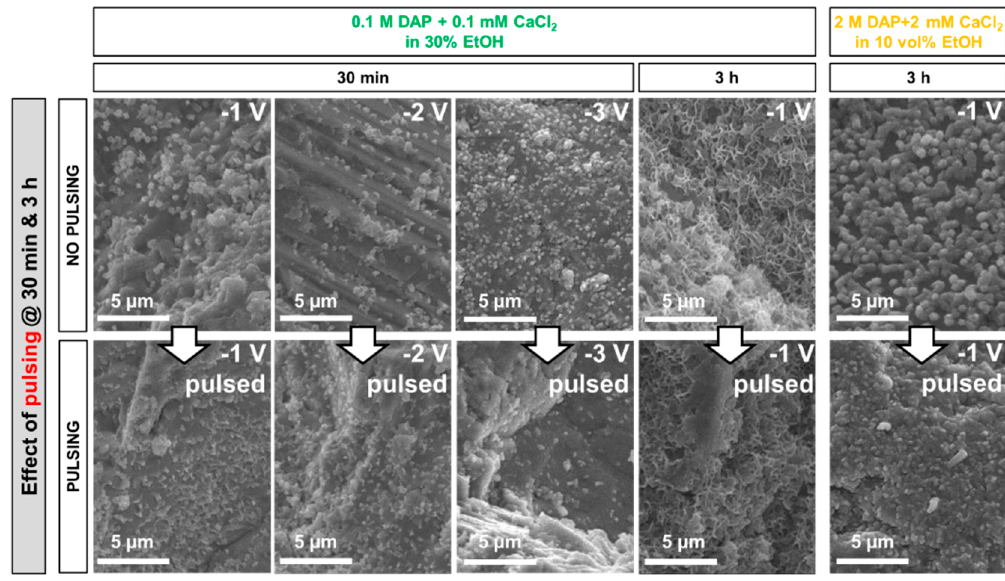
Figure 8. Effect of pulsed potential on the morphology of the new CaP formed at different times.